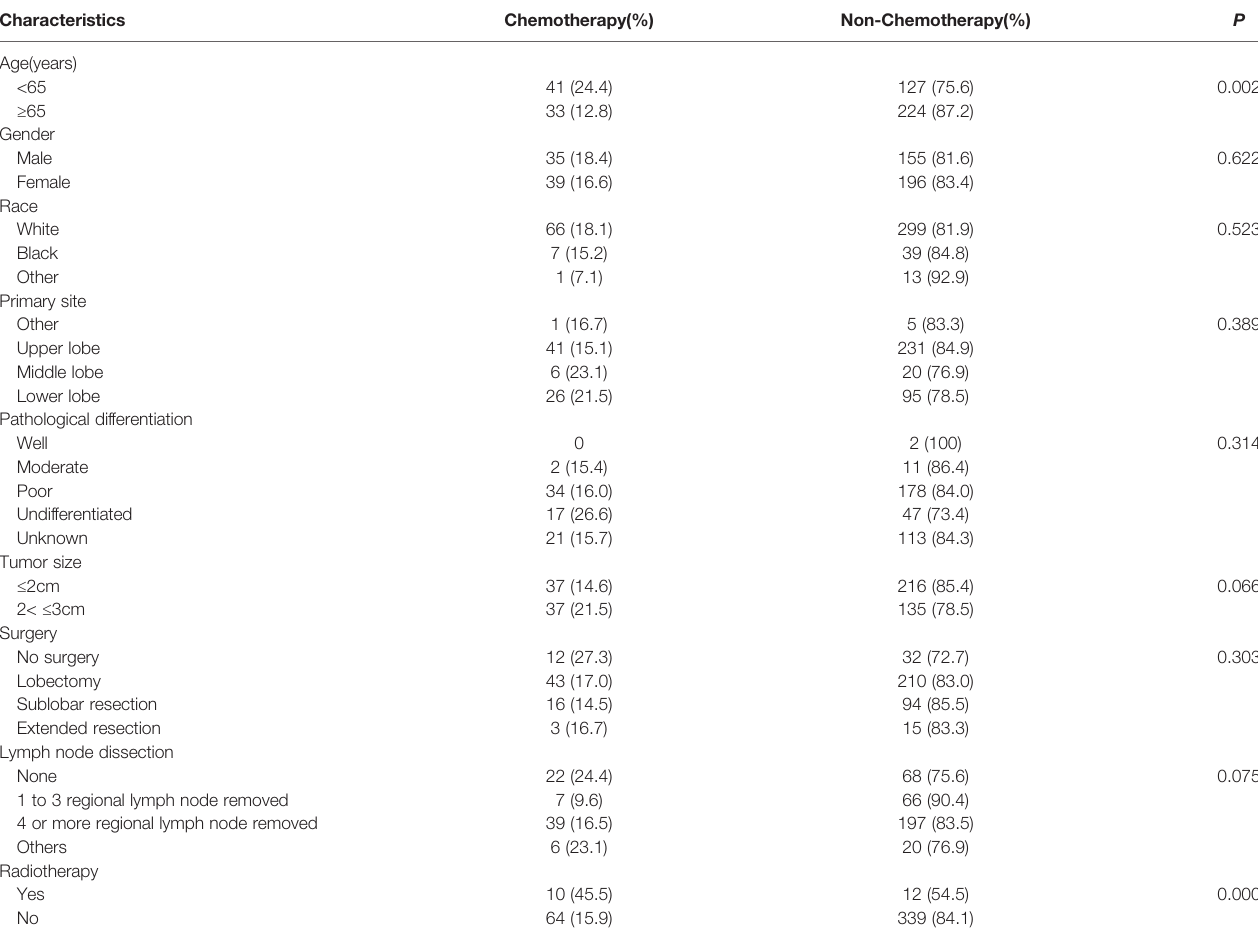
TABLE 2 | Patient characteristics by chemotherapy.